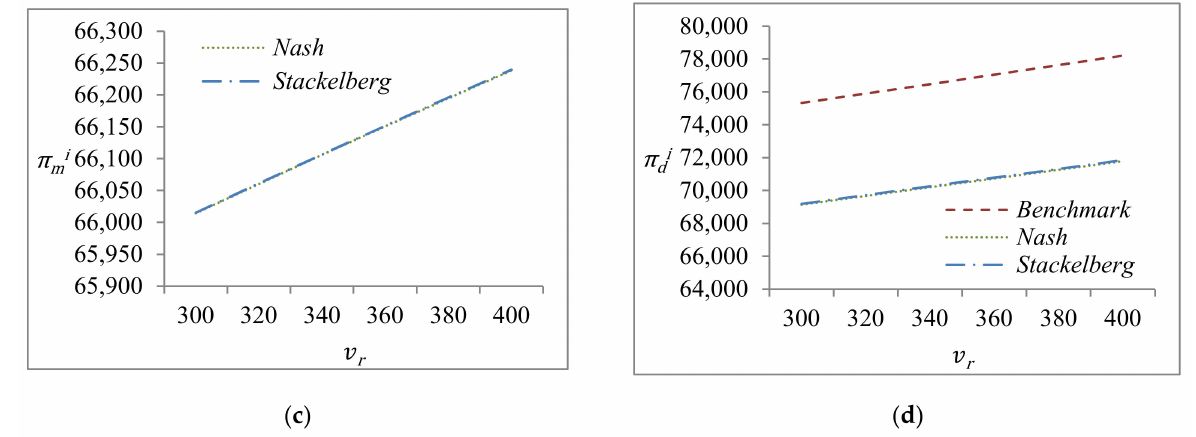
Figure 6. Effect of physical store’s salvage price on: ( a ) manufacturer’s decision; ( b ) retailer’s decision; ( c ) manufacturer’s profit; ( d ) retailer’s profit, when ε value is high. The following market condition is used: r = 0.2, r r = 0.1, ε = 0.02, h = 30, α m = α o = α r = 100, γ = 0.4, γ r = 0.2, p = 900, v r = variable , v o = 20, c d = 420, c m = 100, ∅ = 20.